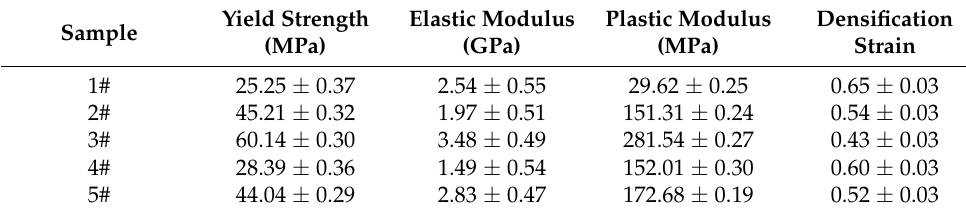
Figure 7. Compressive stress-strain curve of ( a ) different porosity and ( b ) different pore size. Table 2. Mechanical properties of steel